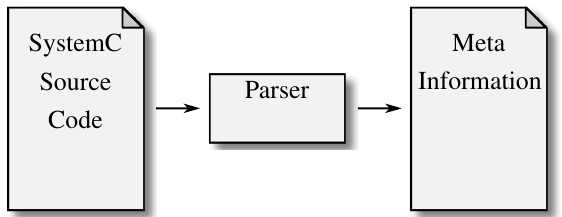
Figure 3. Parsing SystemC: Parsers rely solely on inspecting the source code. While this is a straightforward approach for extracting information and does not rely on a complex architecture, statically analyzing C++ source code is a non-trivial